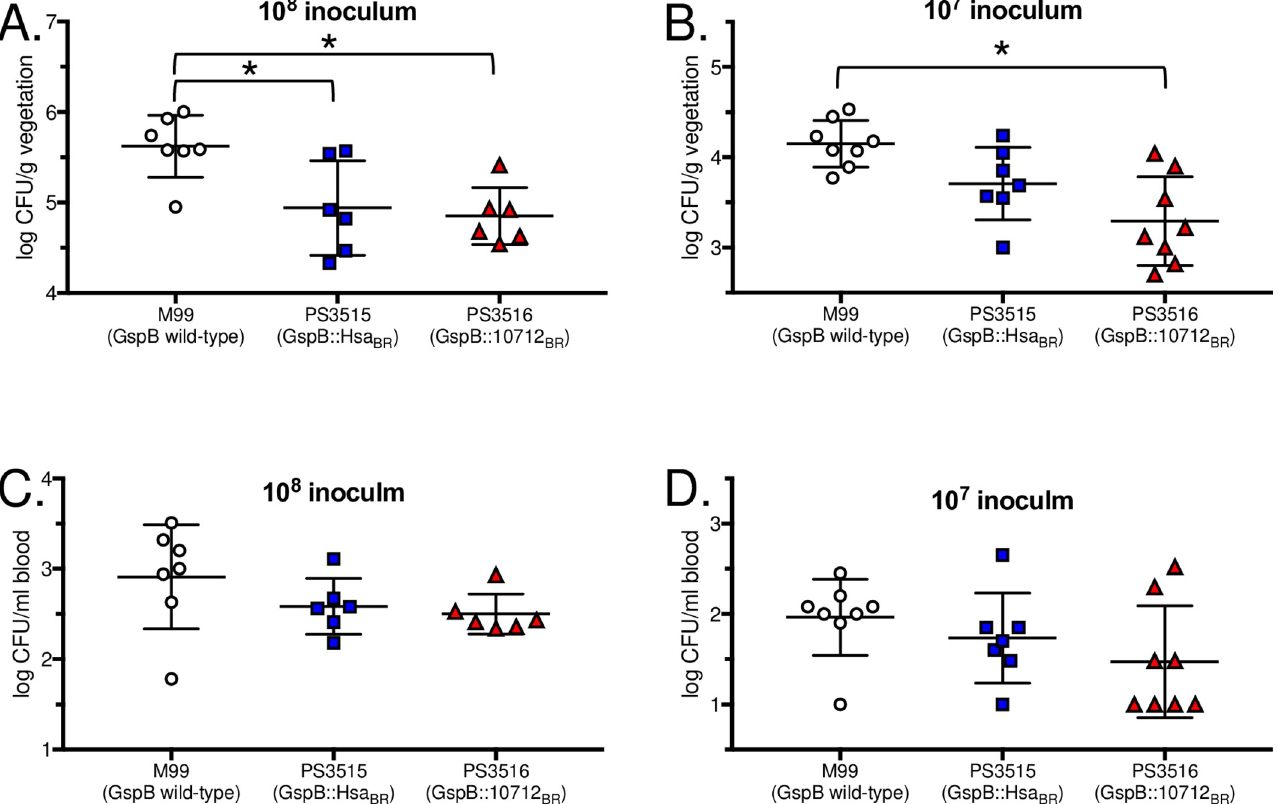
Fig 6. Initial colonization of mechanically-damaged aortic valves. Animals were infected with 10 8 or 10 7 CFU of the indicated strain. At the 10 8 CFU inoculum, n = 7 for M99, and n = 6 for PS3515 and PS3516. For the 10 7 CFU inoculum, n = 8 for M99 and PS3516, and n = 7 for PS3515. Numbers of bacteria attached to aortic valve vegetations (A and B) or in the peripheral blood (C and D) were assessed 1 h post-infection. Asterisks indicate p < 0.05.